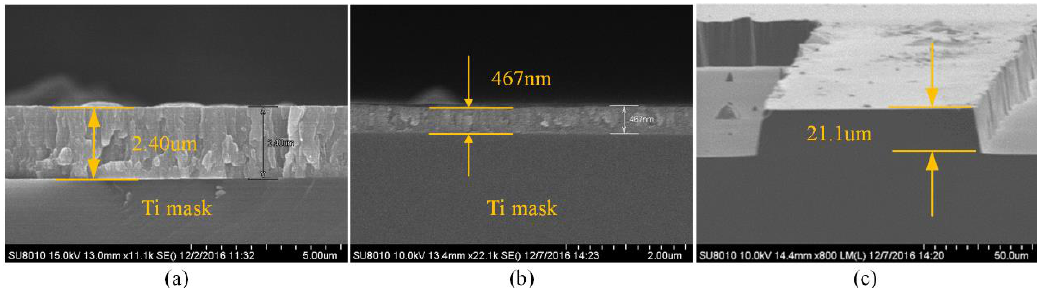
Figure 8. ( a ) SEM image of Al mask before the etching; ( b ) SEM image of the etch profile with Al mask.